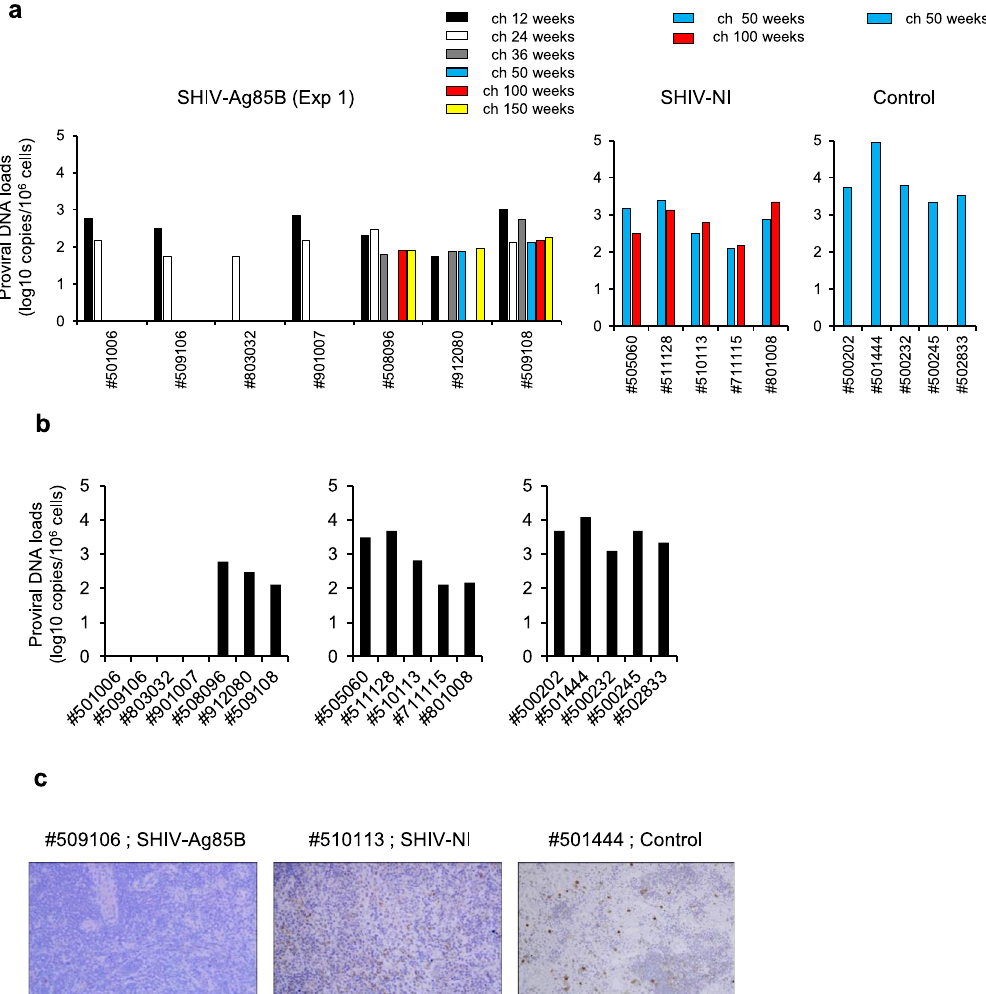
Fig. 5 Kinetics of proviral DNA in macaques inoculated with SHIV-Ag85B or SHIV-NI after pathogenic SHIV89.6P challenge. a Proviral DNA loads in PBMCs of SHIV-Ag85B-inoculated macaques (Exp 1) or SHIV-NI-inoculated macaques after SHIV89.6P challenge as measured by ultrasensitive digital PCR. The detection limit of proviral DNA load was 5 copies per 10 6 cells. b Proviral DNA loads in lymphoid tissues of SHIV- Ag85B-inoculated macaques (Exp 1) or SHIV-NI-inoculated macaques at 34 weeks after the challenge as measured by ultrasensitive digital PCR. c Immunohistochemical detection of SHIV Nef antigen in inguinal lymph nodes at 34 weeks after the challenge. Brown staining indicates SHIV Nef-positive cells. Magni fi cation ×200. Black scale bars, 100 μ